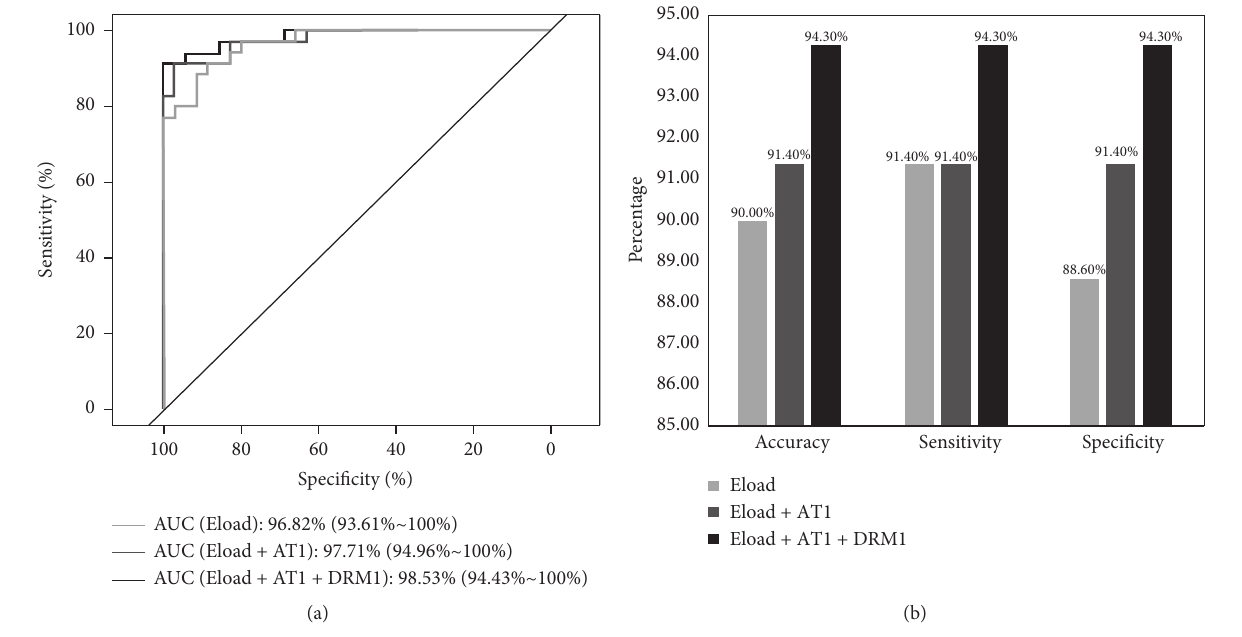
Figure 1: (a) Receiver operator characteristic curve for each step of the forward logistic regression in IOP-matched scenario (35 keratoconus and 35 normal eyes). (b) Gain in sensitivity and specificity with each step of the logistics regression to establish the novel NPS with IOP- matched scenario (35 keratoconus and 35 normal eyes; best cut-off point � 0.5).